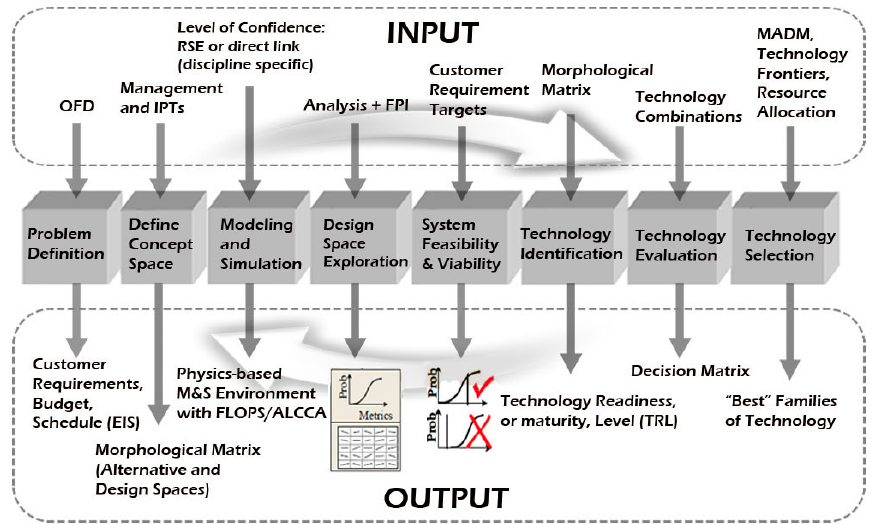
Figure 1. Procedure and composition of the technology identification, evaluation, and selection (TIES) method. RSE, Response Surface Evaluation; QFD, Quality Function Deployment; IPT, Integrated Product Team; FPI, Fuzzy Performance Index; MADM, Multi Attribute Decision Making; EIS, Enterprise Investment Scheme; FLOPS, Flight Optimization System Program; ALCCA, Aircraft Life Cycle Cost Analysis.